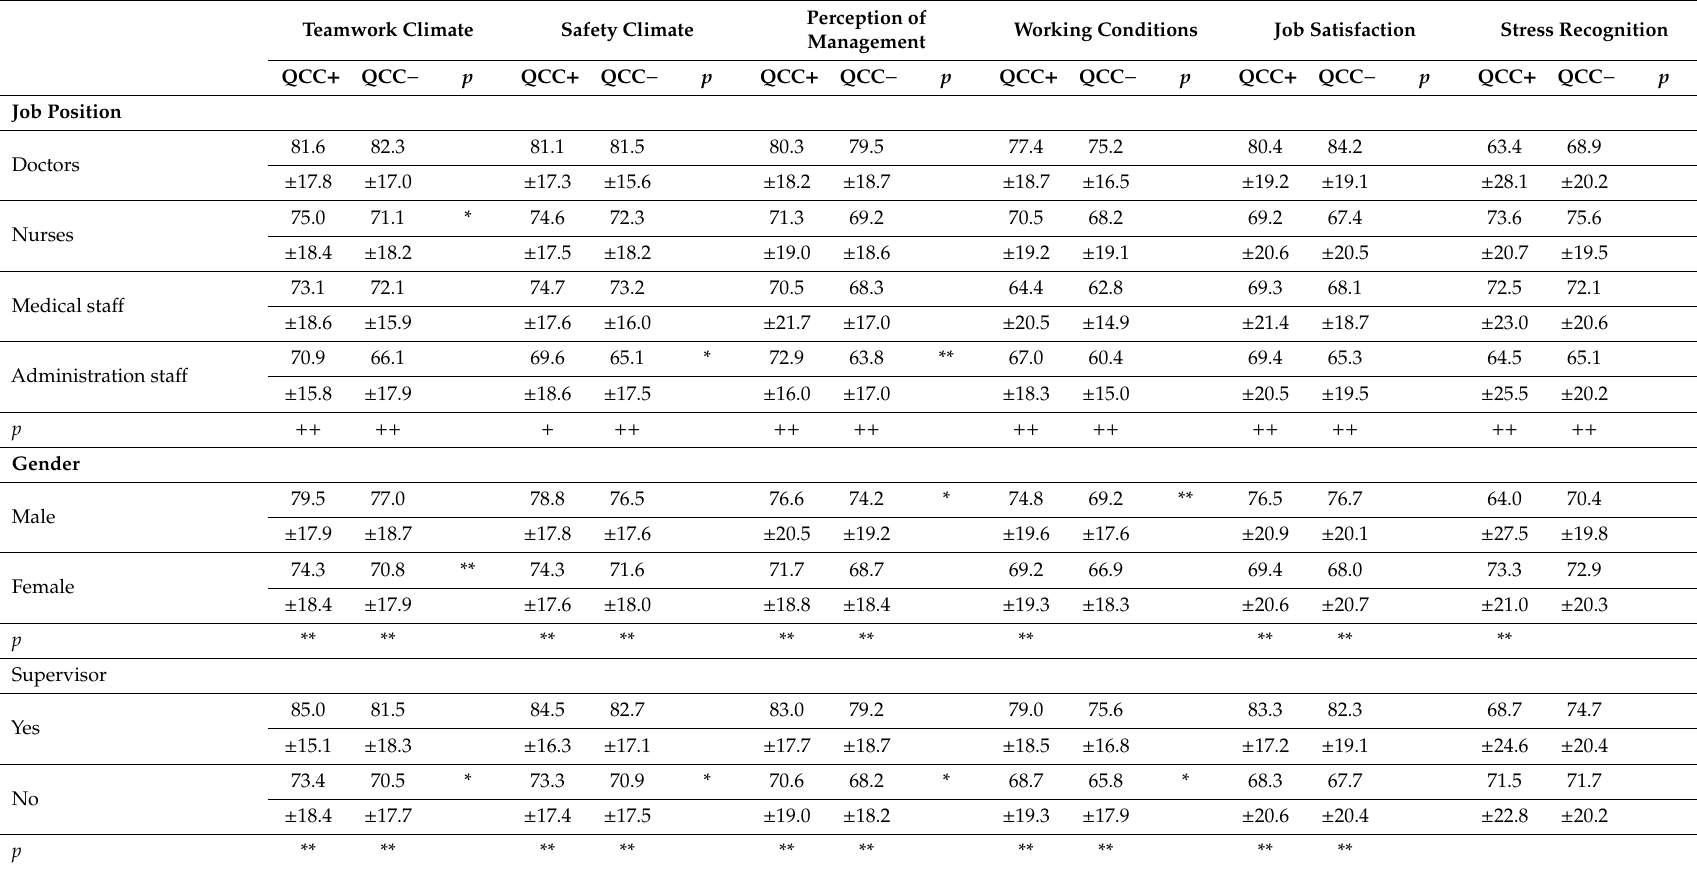
Table 3. Scores of six subscales shown according to participants with or without